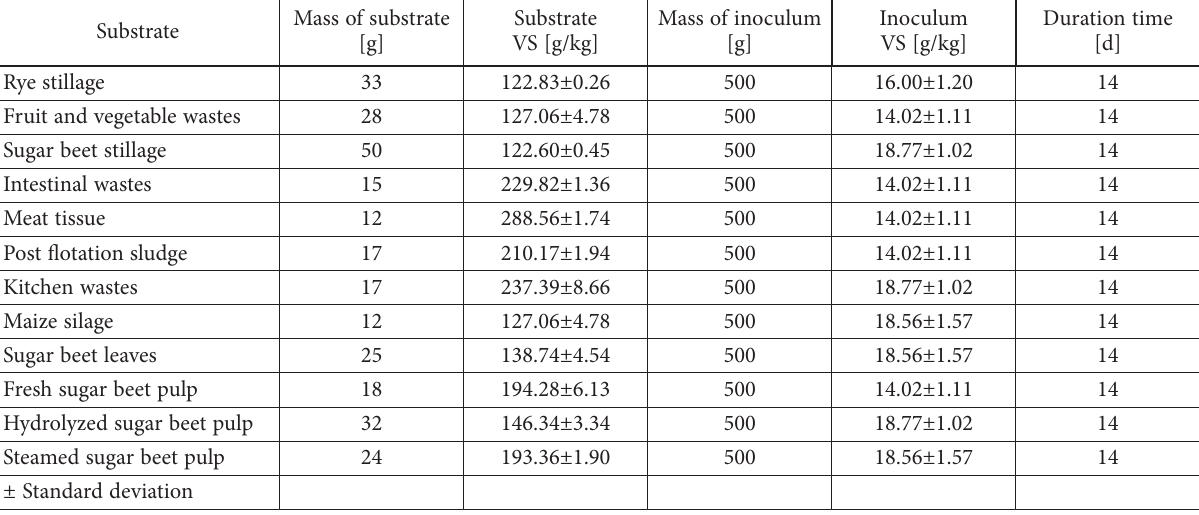
Table 2. Parameters of the batch digestion tests